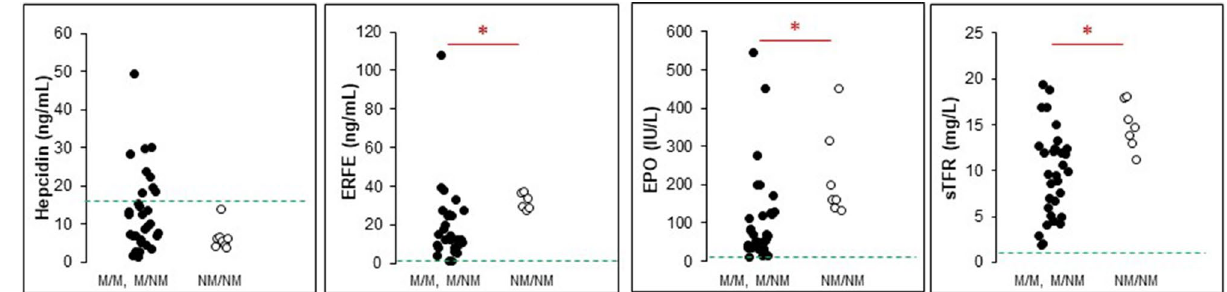
Figure 3. Distribution of hepcidin, EPO, ERFE, and sTfR in PKD patients grouped according with their genotype. Green lines represent median control’s values. *P < 0.001, Mann–Whitney test. Reference ranges for each variable are reported in Table